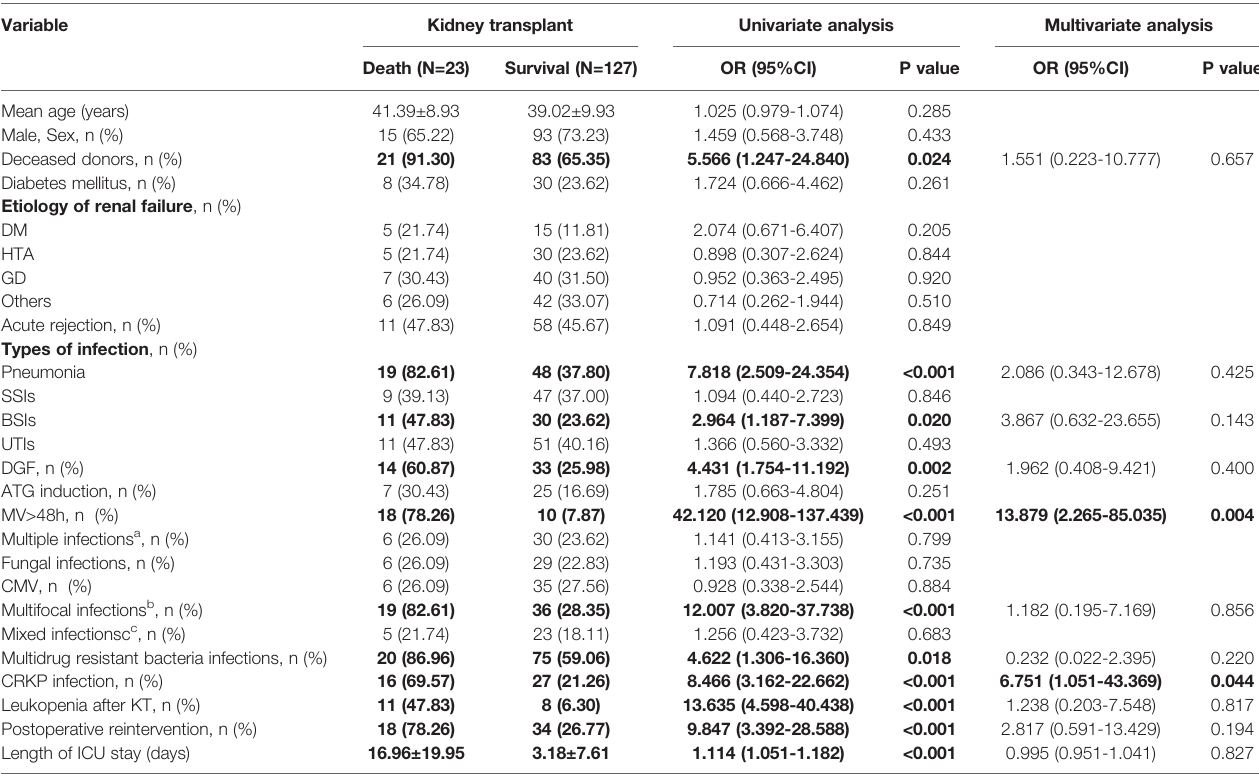
TABLE 1 | Univariate and multivariate analysis of risk factors for one-year mortality in 150 kidney transplant recipients with early infection. Variable Kidney transplant Univariate analysis Multivariate analysis